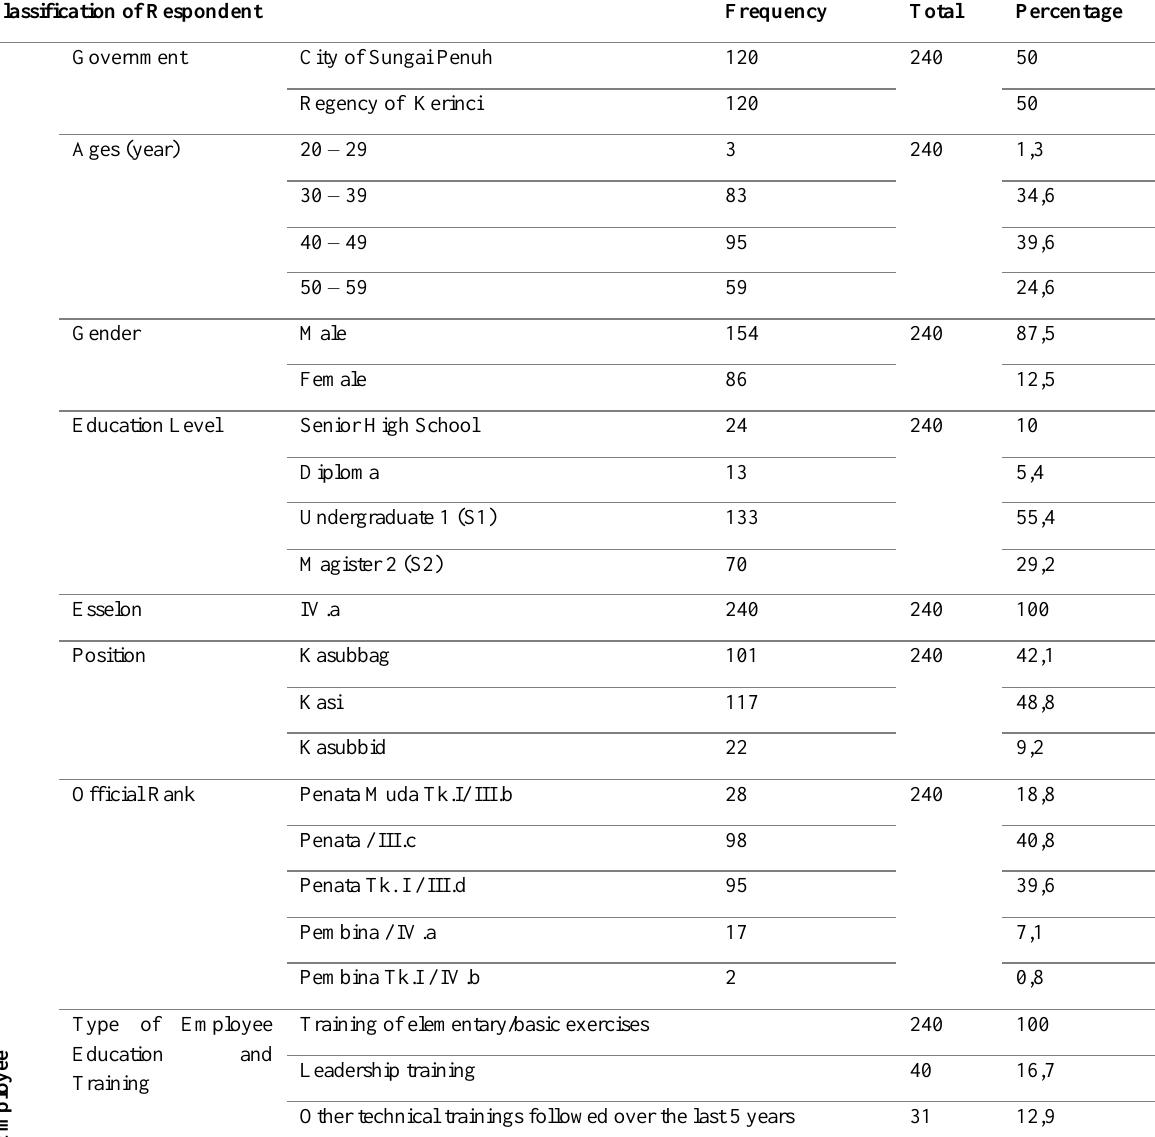
Table 2 : Profile respondent of officers who evaluated in supervisor